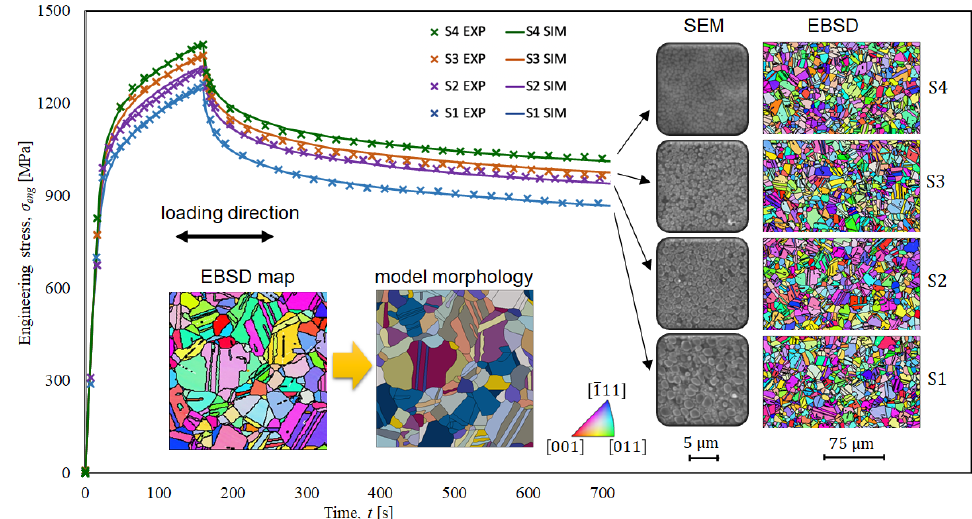
Figure 1. Calibrations of the stress-relaxation results for the superalloys with four different γ ’ precipitate sizes using crystal plasticity based on realistic microstructures.